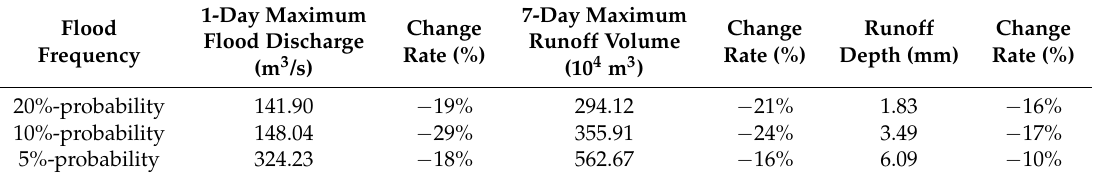
Table 8. The results of three indictors of S1.